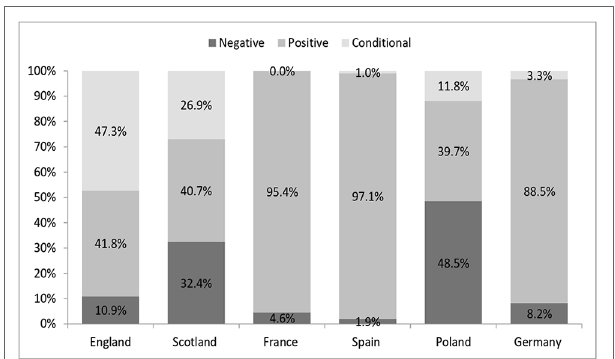
FIGURE 1 | Percentage of positive, negative, and conditional reimbursement recommendations for orphan drugs (all) in analyzed